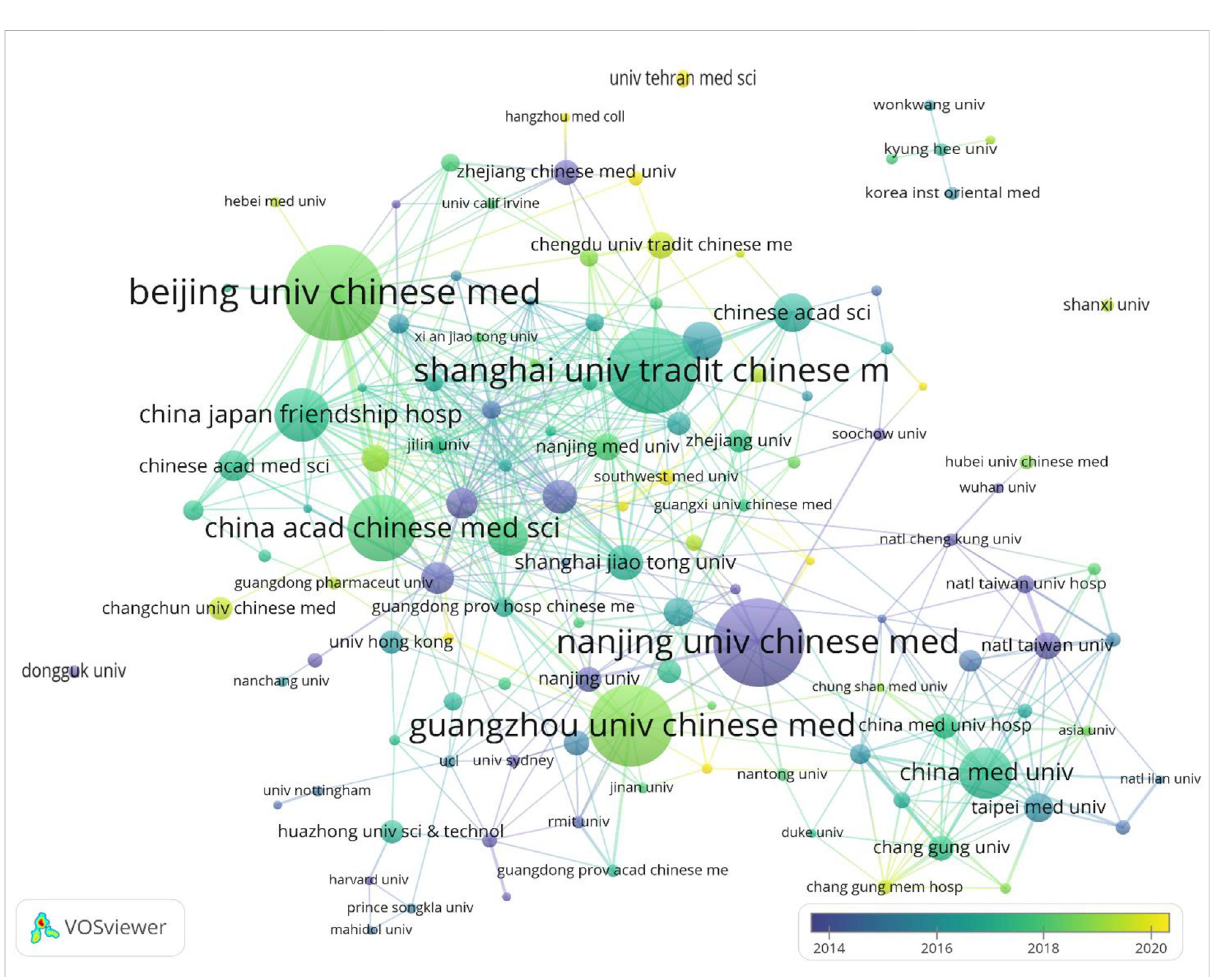
FIGURE 3 Institutions coauthorship network visualization